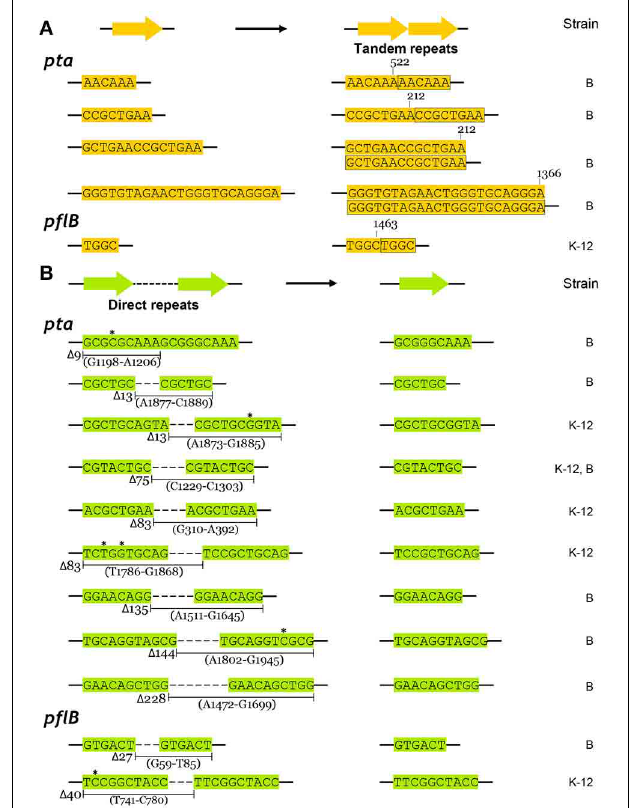
adapted K-12 and B mutants. (A) Insertional mutations were generated by precise tandem repeats, and (B) deletions between perfect or imperfect direct repeats were observed. Mismatched bases in direct repeats were indicated by asterisks.